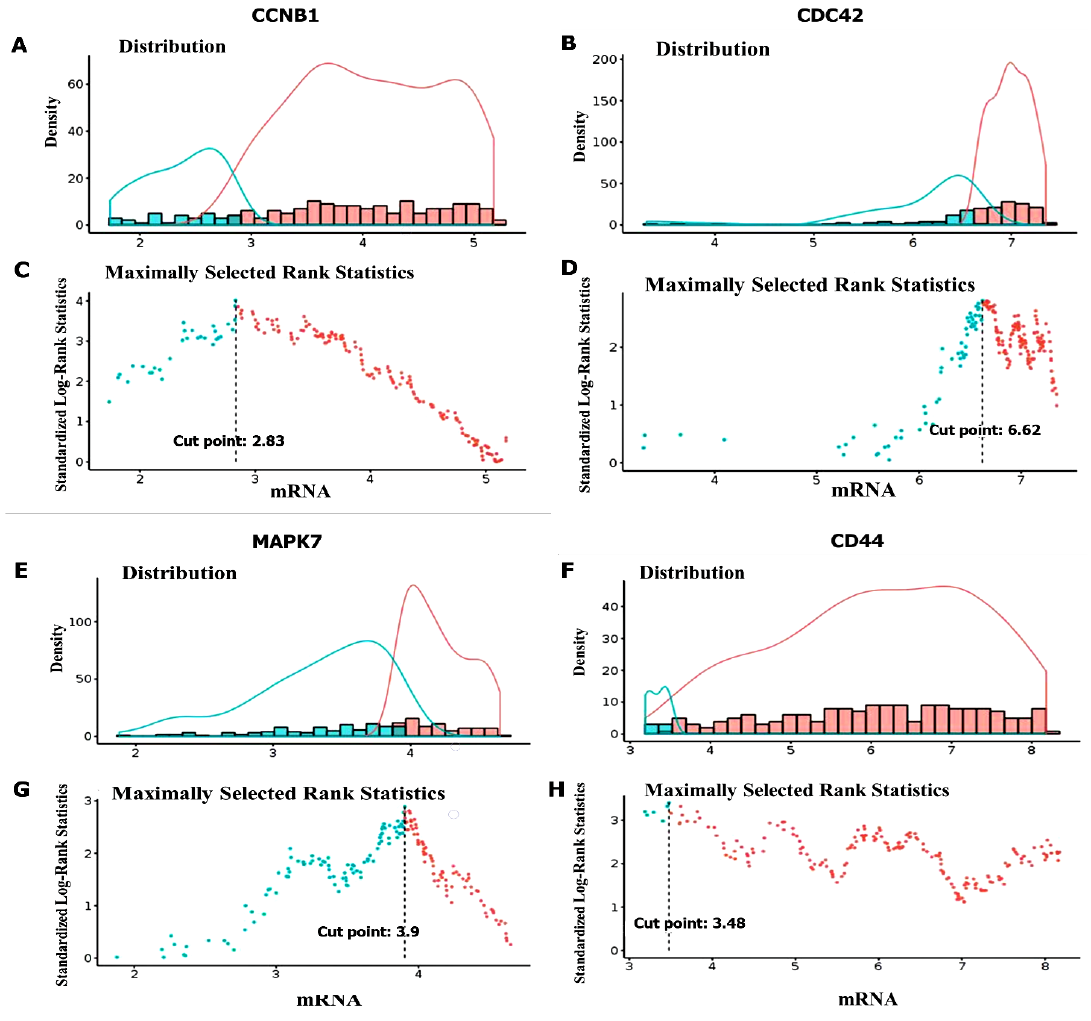
Figure 8. Optimal cutoff score calculations of Radscores of CCNB1, CDC42, MAPK7, and CD44 expressions in glioblastoma multiforme (GBM). ( A , B ) Radscores plot of CCNB1 with a cutoff value of 2.83. ( C , D ) Radscores plot of CDC42 with a cutoff value of 6.62. ( E , F ) Radscore plot of MAPK7 with